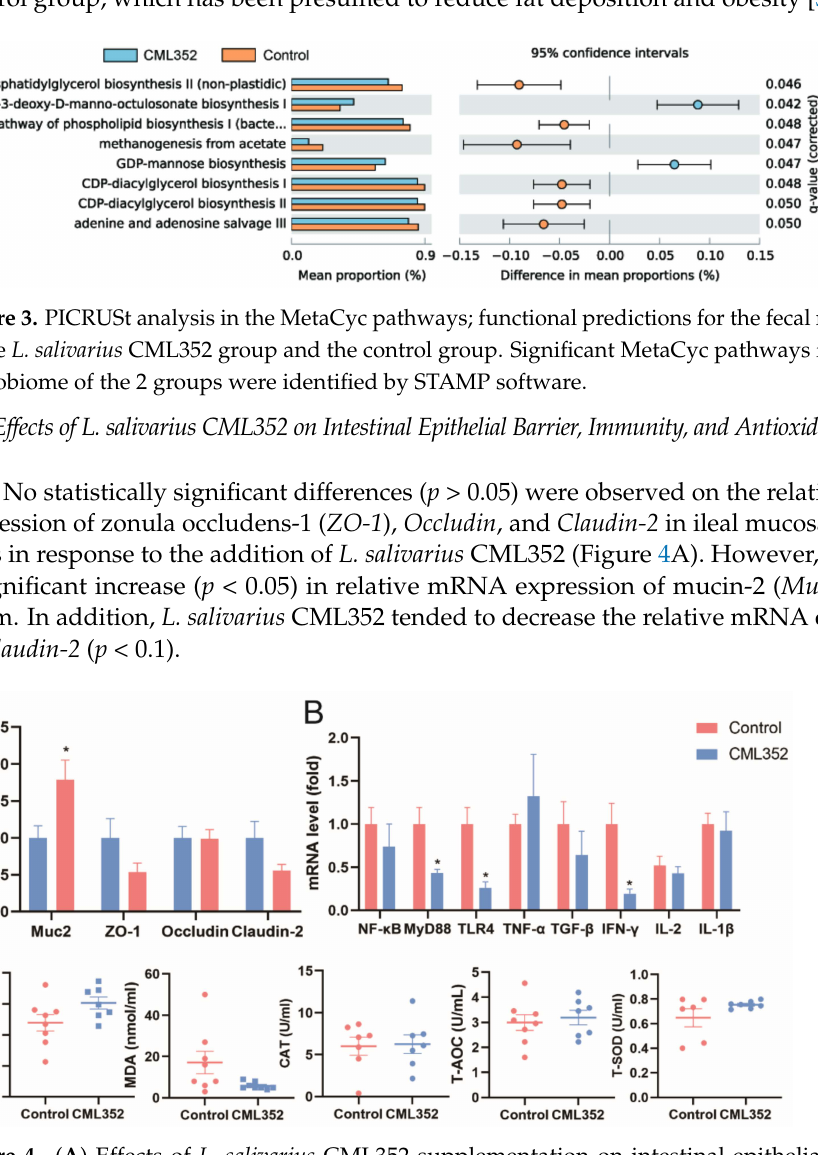
Figure 4. ( A ) Effects of L. salivarius CML352 supplementation on intestinal epithelial barrier in ileum of laying hens. Total RNA was extracted and the expressions of Muc-2 , ZO-1 , Occludin and Claudin-2 and were measured by real-time PCR; ( B ) effects of L. salivarius CML352 supplementation on immunity in ileum of laying hens. Total RNA was extracted and the expressions of NF- κ B , MyD88 , TLR-4 , TNF- α , TGF- α , IFN- γ , IL-2 , and IL-1 β were measured by real-time PCR; ( C ) effects of L. salivarius CML352 supplementation on serum antioxidant of laying hens. Data are expressed as mean ± SEM from three independent experiments. Asterisks indicated values significantly different ( p < 0.05) between the